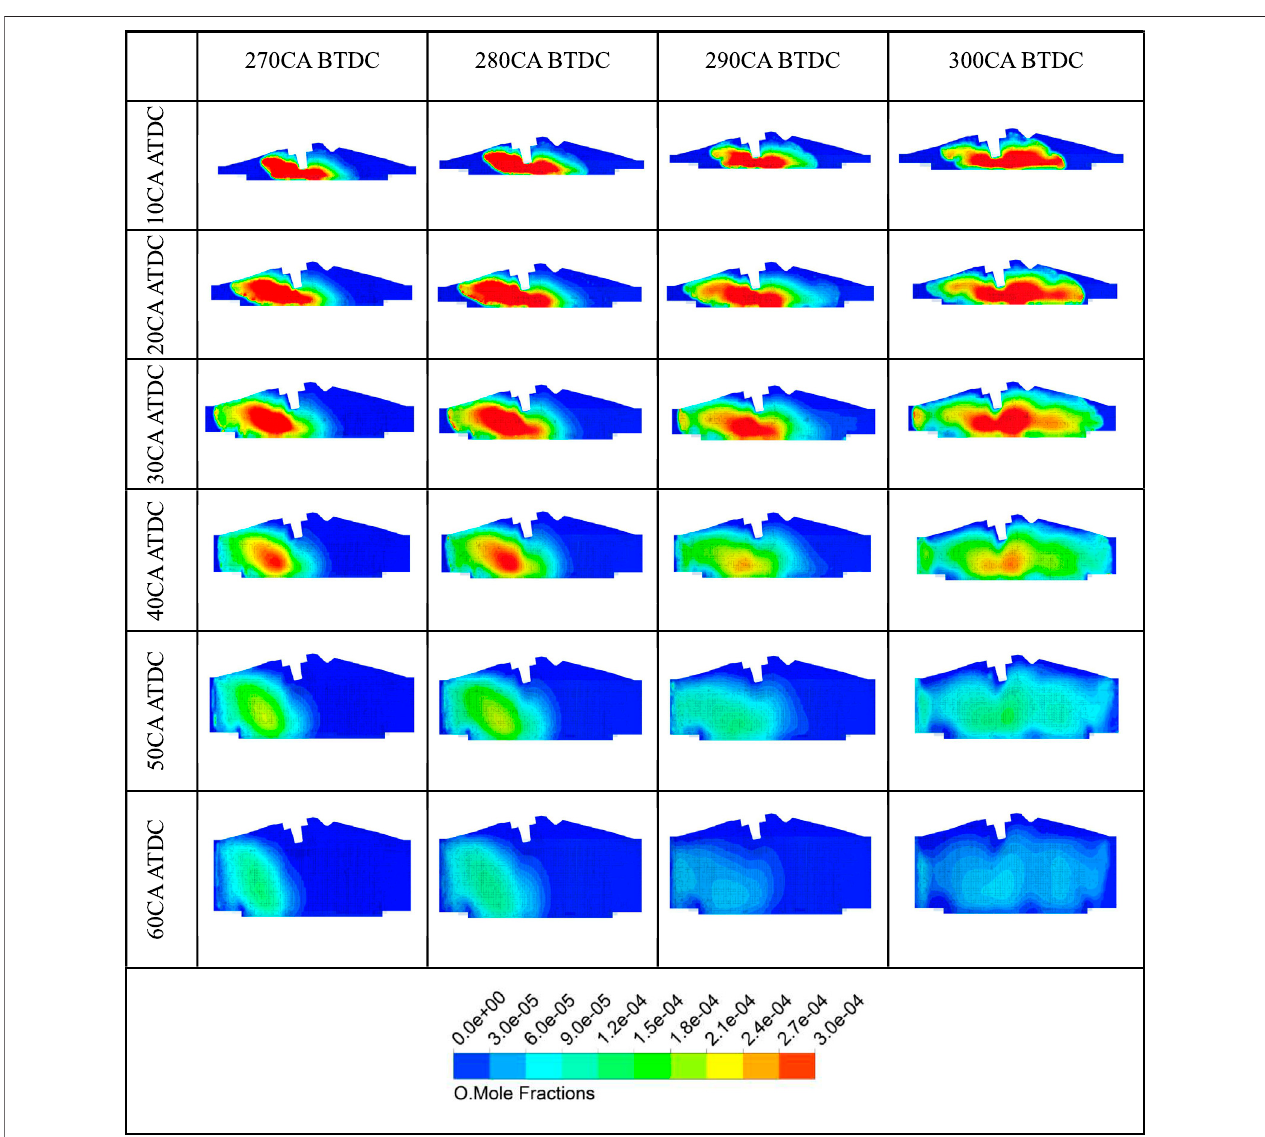
FIGURE 11 | Effect of injection timing on O formation at several CAD in combustion